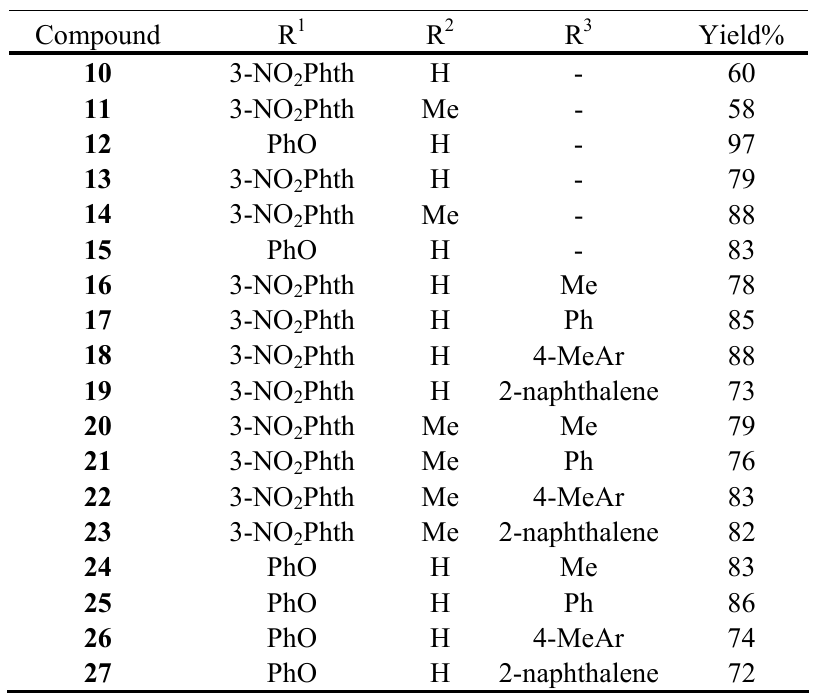
Table 1 . Monocyclic β